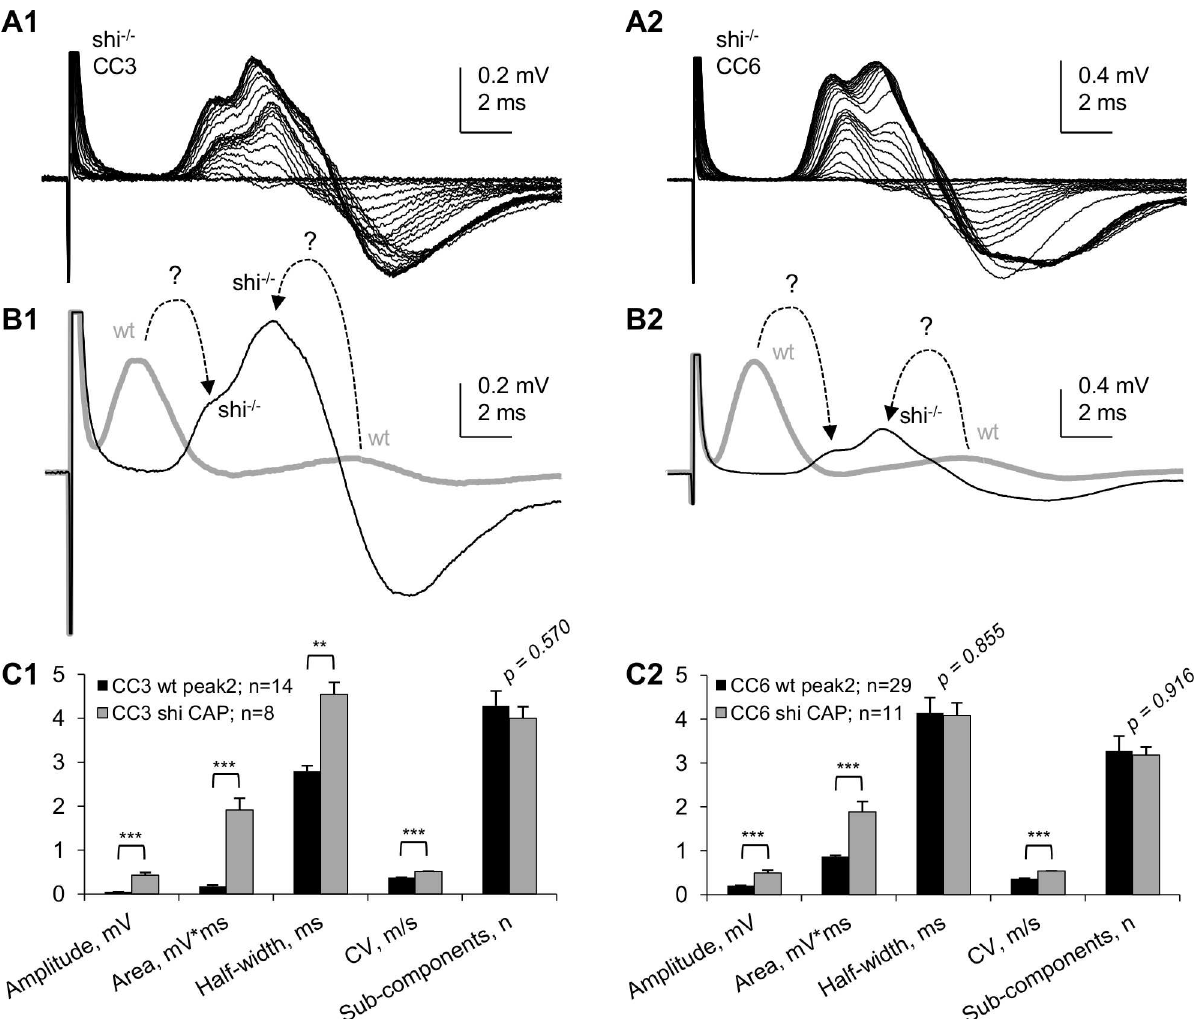
Fig 5. Comparison of “whole” CC CAPs of wild type (wt) and dysmyelinated shiverer (shi -/- ) mice. (A1, A2) Superimposed “whole” CC CAPs recordedat varyingstimulationintensitiesin CC3 (A1) and CC6 (A2). Each trace in A1 and A2 represents an averageof 6 consecutive recordingstaken at 10 s intervals. (B1, B2) Digitallyaveraged“whole” CC CAPs recordedfrom wt (thick gray traces) and shi -/- (thin black traces) CC3 (B1, digitallyaveragedfrom 8 experiments) and CC6 (B2, digitallyaveragedfrom 11 experiments). CAPs from wt CCs, (digitallyaveraged,from Fig 4A1 and 4A2; brought to same scale with shi -/- CAPs) are shown in B1 and B2 as thick gray traces. Dashedarrows with questionmarks show hypothetical relationships betweenpeaks of wt and shi -/- CAPs (see text). (C1, C2) Statistical comparisonof main parameters of wt and shi -/- “whole” CC CAPs. ** p < 0.01; *** p <